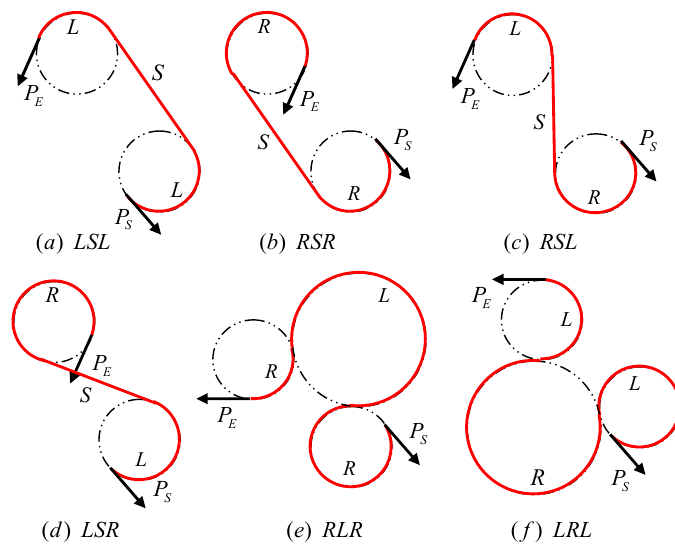
Figure 13. The main types of DUBINS path. P S represents the beginning speed direction, P E represents the ending speed direction, S represents the straight line, R represents the right turn, and L represents the left turn. ( a ) LSL means that the HSA starts from the beginning point P S , first turns left, then goes straight line, and finally turns left to the ending point P E . ( b ) RSR means that the HSA starts from the beginning point P S , first turns right, then goes straight line, and finally turns right to the ending point P E . ( c ) RSL means that the HSA starts from the beginning point P S , first turns right, then goes straight line, and finally turns left to the ending point P E . ( d ) LSR means that the HSA starts from the beginning point P S , first turns left, then goes straight line, and finally turns right to the ending point P E . ( e ) RLR means that the HSA starts from the beginning point P S , first turns right, then turns left, and finally turns right to the ending point P E . ( f ) LRL means that the HSA starts from the beginning point P S , first turns left, then urns right, and finally turns left to the ending point P E .